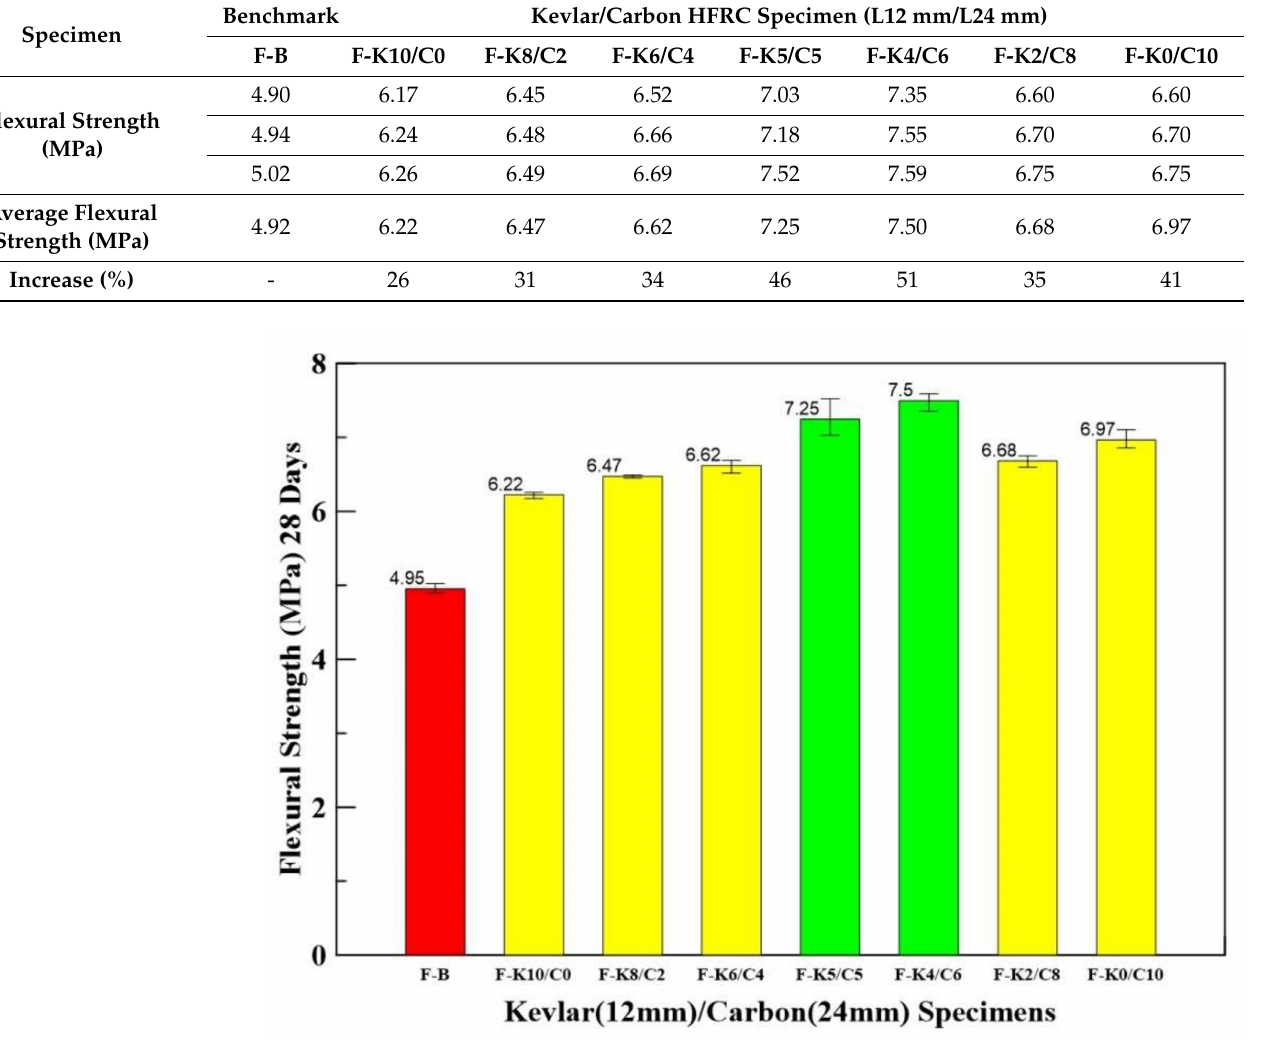
Figure 8. Bar chart for average flexural strengths of benchmark and Kevlar/carbon HFRC specimens. Table 7 shows the flexural strength of benchmark and carbon (12 mm)/ Kevlar (24 mm) HFRC with different mix-proportion specimens. The mixed proportions of carbon/ Kevlar HFRC specimens increased their flexural strength by 22~45% compared with benchmark specimens. The F-C6/K4 and F-C5/K5 have higher flexural strength than others, and they increase by 40 and 45%, respectively. The average flexural strengths of HFRC are shown in Figure